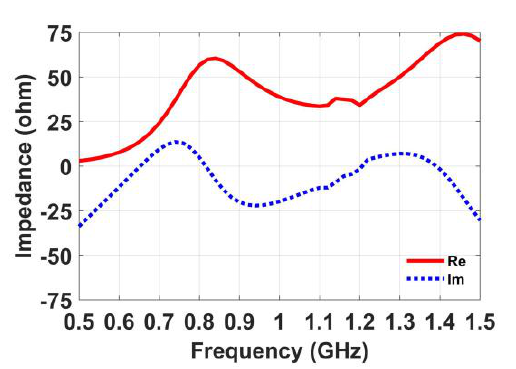
Figure 8. The geometry of the proposed UHF antenna.